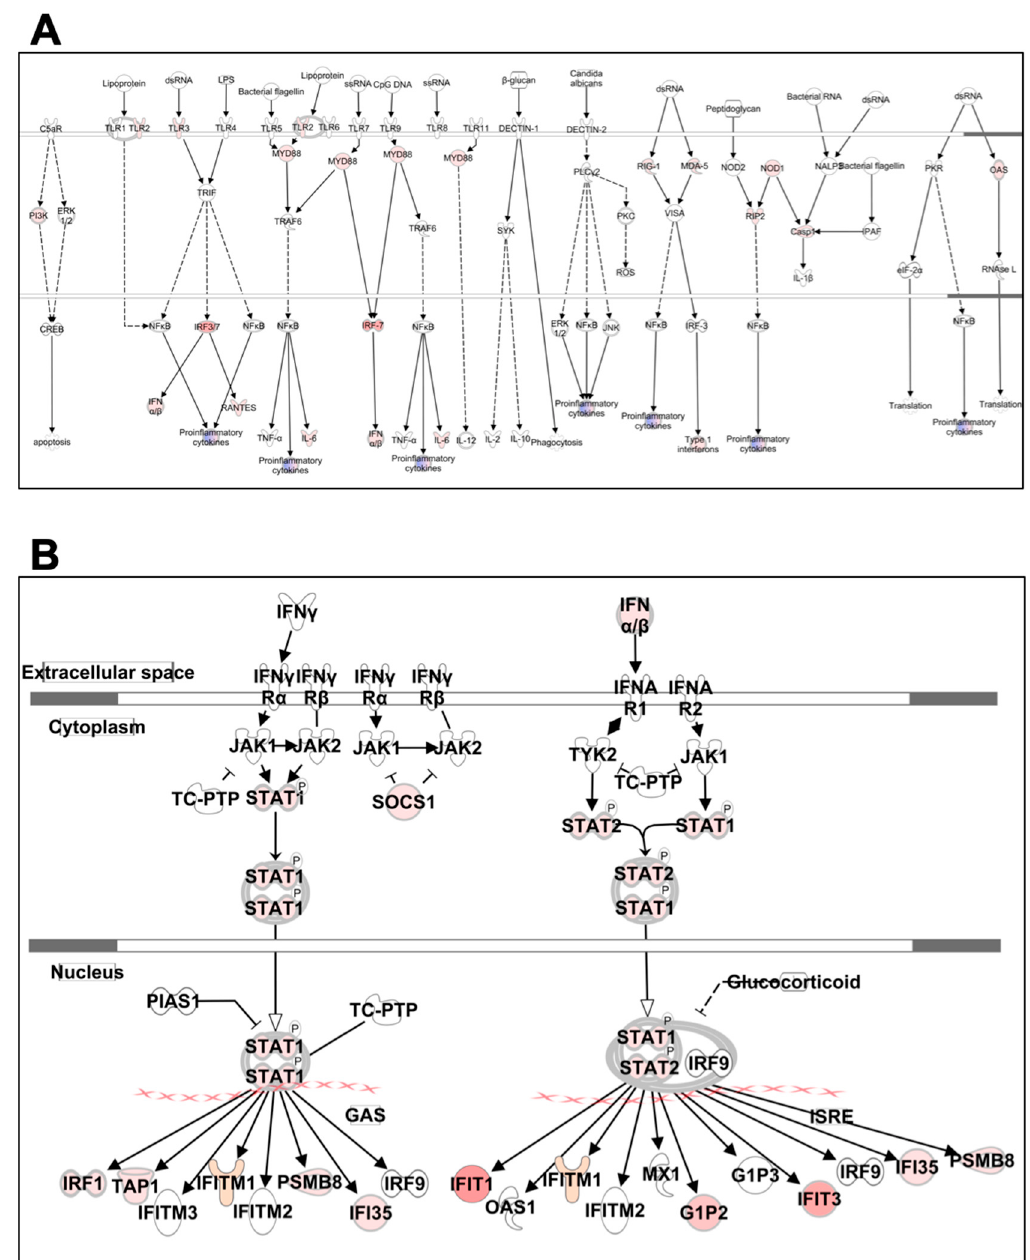
Figure 6. Pathway analysis for PRR and IFN signaling. Genes associated with ( A ) PRR and ( B ) IFN signaling activated by ZIKV infection are shown. Differentially expressed mRNAs are highlighted in color. Color intensity indicates the degree of upregulation (red) relative to the mock-infected neurons. Solid lines represent direct interactions and dashed lines indirect interactions. Shading intensity indicates the degree that each mRNA was upregulated.